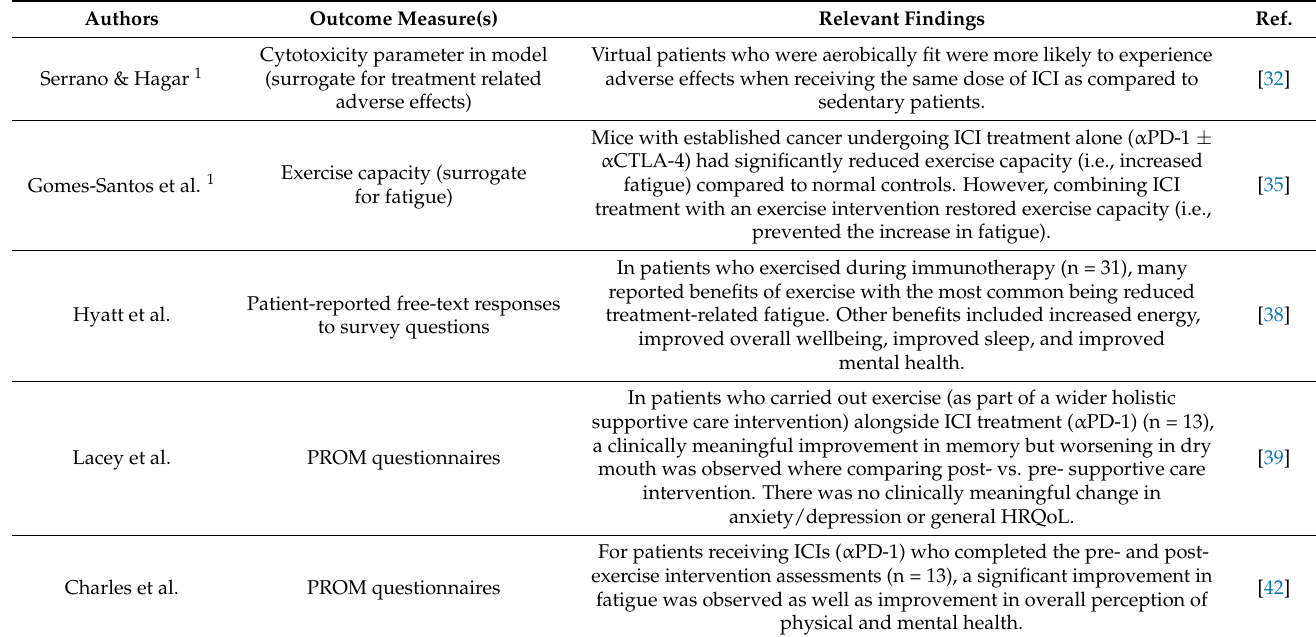
Table 4. Findings from studies addressing the impact of exercise on QoL in the context of ICIs (n = 5).